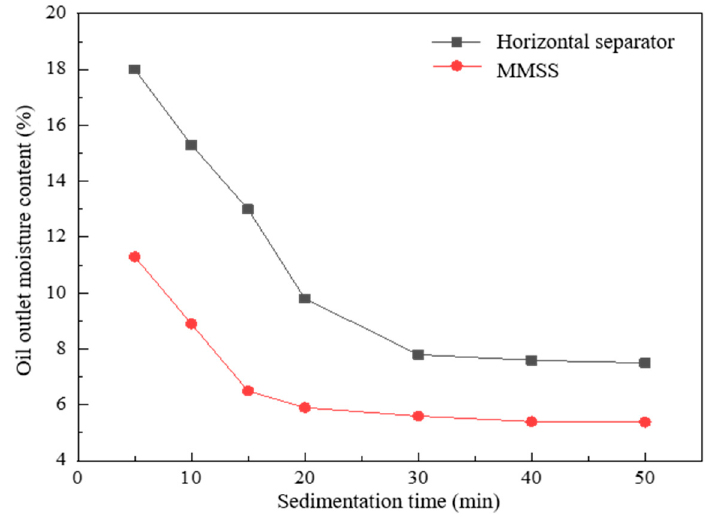
Figure 11. Change in water content of the oil outlet with settlement time.